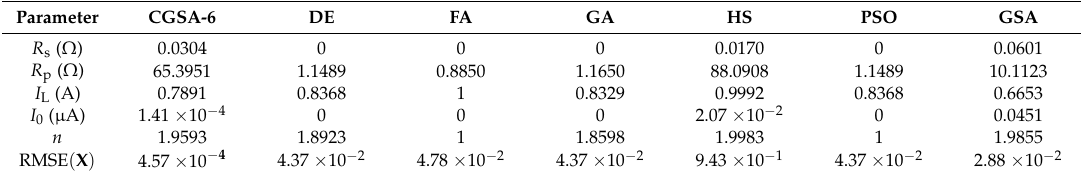
Table 12. PV cell parameters for the DD model, extracted by applying CGSA-6, DE, FA, GA, HS, PSO and GSA. Note that best RMSE value from among the applied methods is boldfaced.